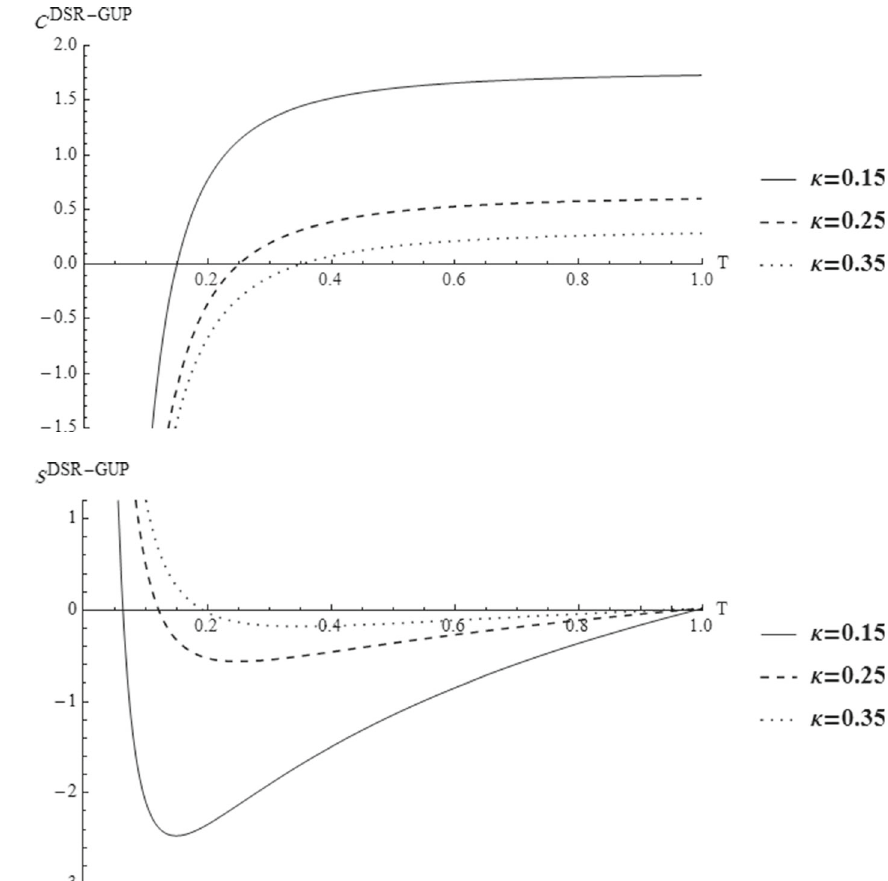
Figure 5, modified entropy vs. temperature, represents a min- imum and then tends to zero for large enough